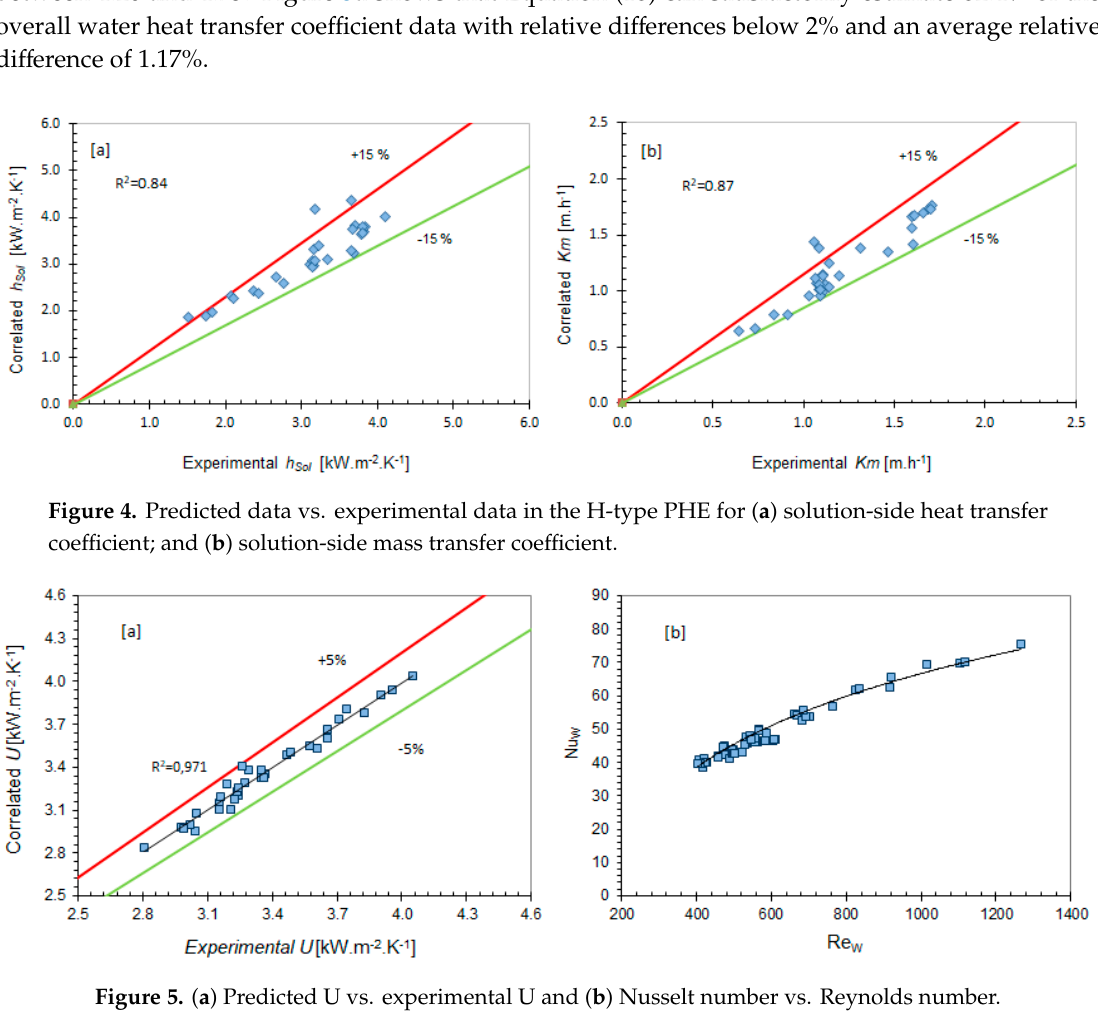
Figure 5. ( a ) Predicted U vs. experimental U and ( b ) Nusselt number vs. Reynolds number.